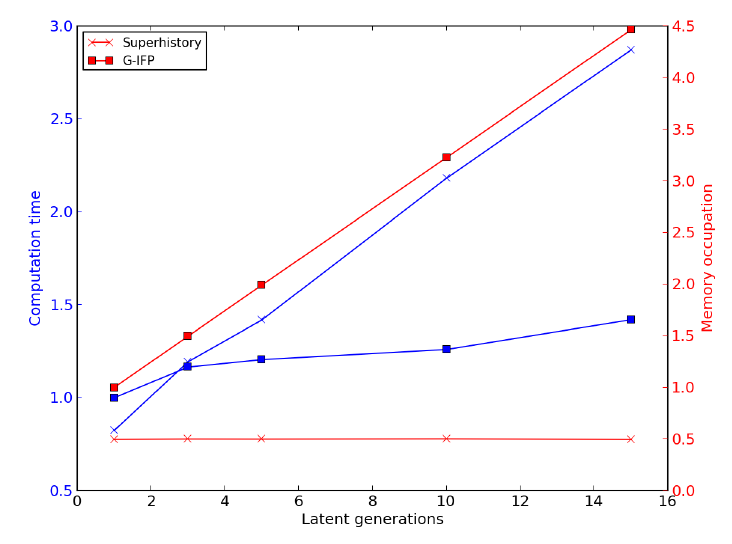
Figure 3: Memory occupation (red curves) and computation time (blue curves) for the G-IFP (squares) and the super-history (crosses) methods as a function of the latent generations (or equivalently inner cycles). The displayed figures have been normalized to the G-IFP values with M = 1 latent